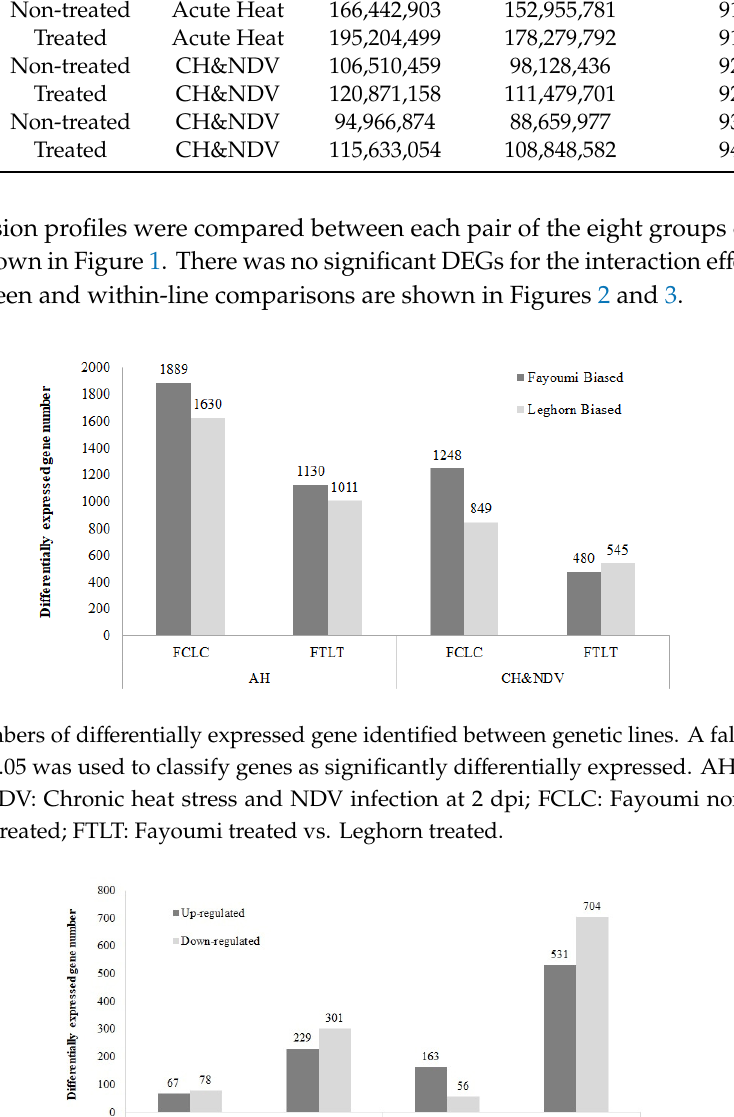
Figure 3. Numbers of differentially expressed gene identified within genetic lines. A false discovery rate < 0.05 was used to classify genes as significantly differentially expressed. AH: Acute heat stress; CH&NDV: Chronic heat stress and NDV infection at 2 dpi; LTLC: Leghorn treated vs. non-treated; FTFC: Fayoumi treated vs. non-treated.